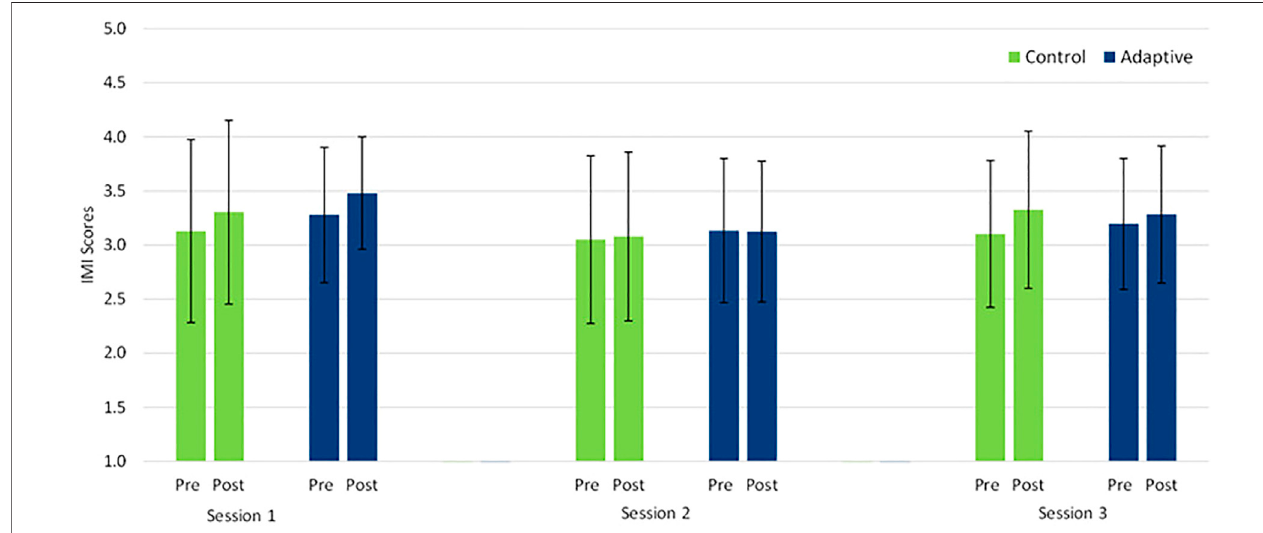
FIGURE 3 | IMI values prior to and post tutoring for both conditions across all sessions. Error bars represent SDs.